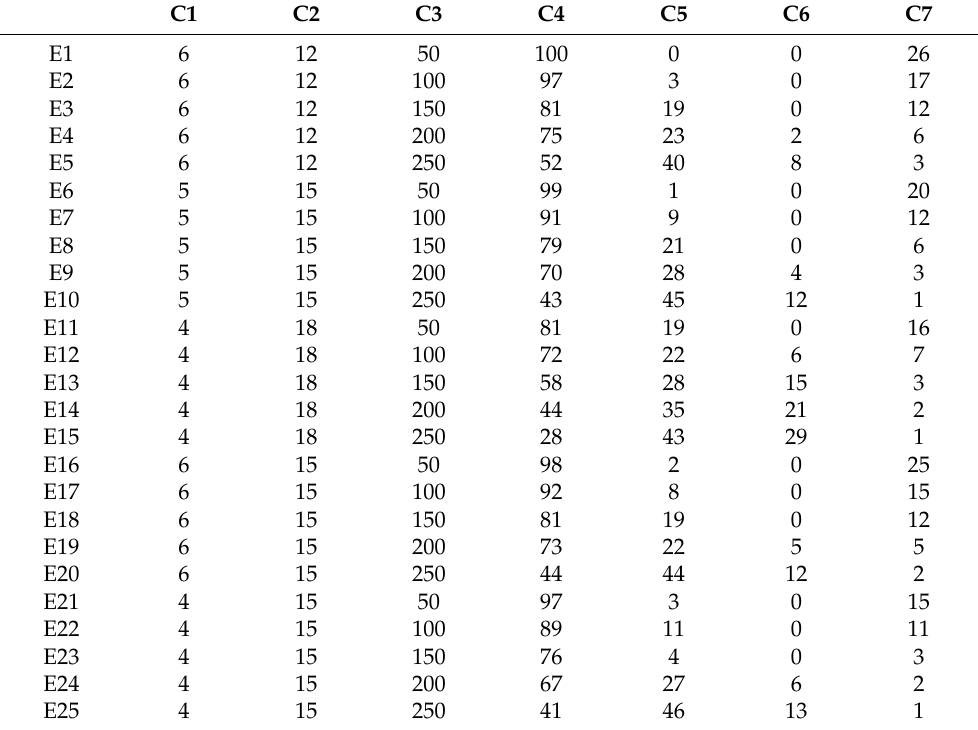
Table 1. Results of research on seeding